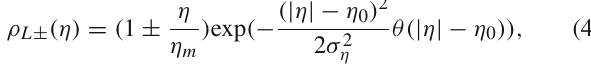
between the multiplicity of charged hadrons and the num- ber of wounded